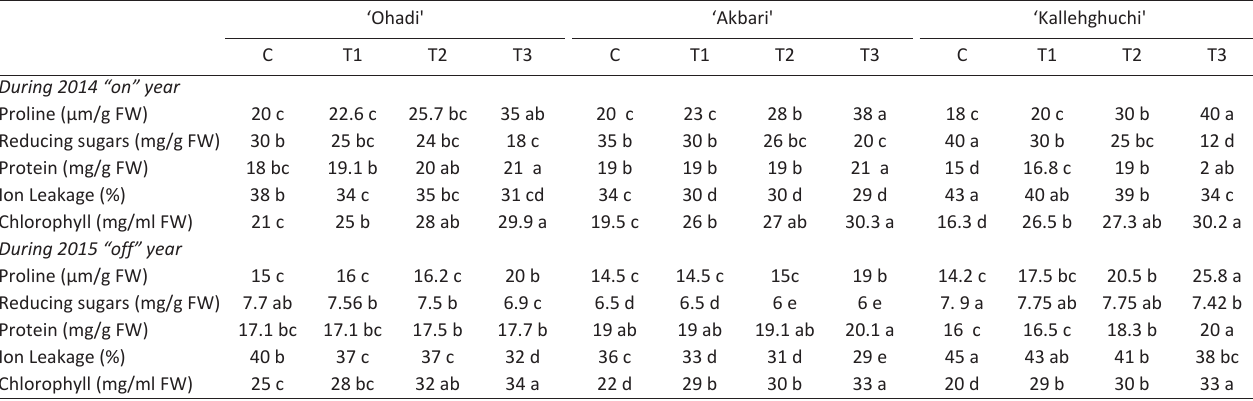
C= Control, T1= Bud swelling phase, T2= Two weeks after full bloom, T3= T1 and T2. Different letters within a row indicate significant differences by Duncan’s multiple range tests at